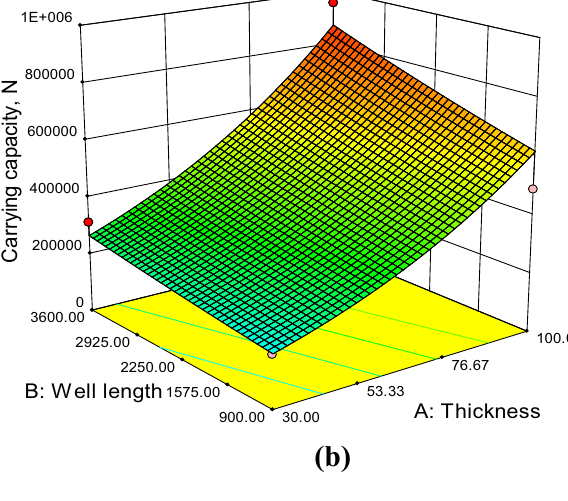
Fig. 10 Response surfaces for carrying 0.95. Figure 9a shows a cross-plot of the predicted values of carrying capacity using Eq. 9 and the actual values. Figure 9b presents the residuals plotted on a normal probability graph, wherein the straight-line signature indicates normal distribution. Figure 10a, b is response surfaces constructed with Eq. 9, and they show how the carrying capacity varies with the changes in independent variables. Note that Fig. 10a reflects the response surface when the fracture half-length is at its smallest value, whereas Fig. 10b shows the same when the fracture half-length is at its largest value.